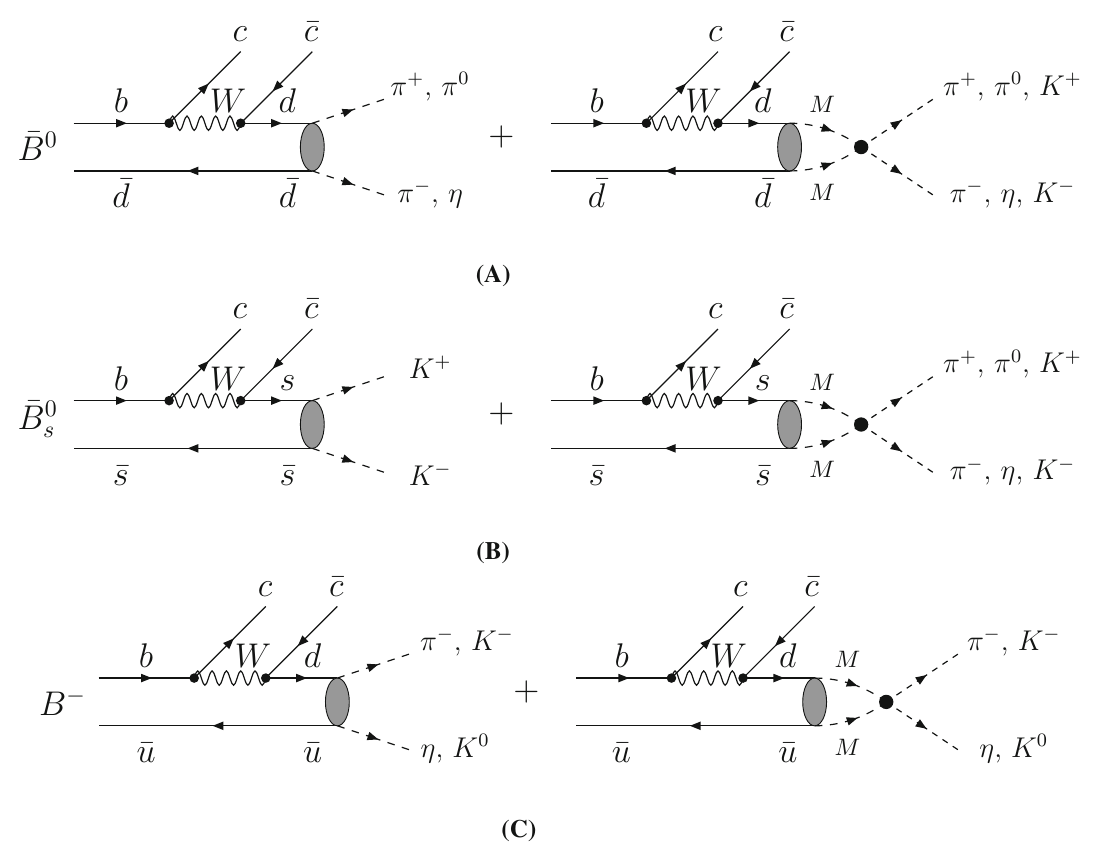
Fig. 2 Diagrammatic representations of the production of π + π − , π 0 η , K + K − , π − η , and K − K 0 via direct plus re-scattering mechanisms in ¯ B 0 ( a ), ¯ B 0 s ( b ) and B − ( c )